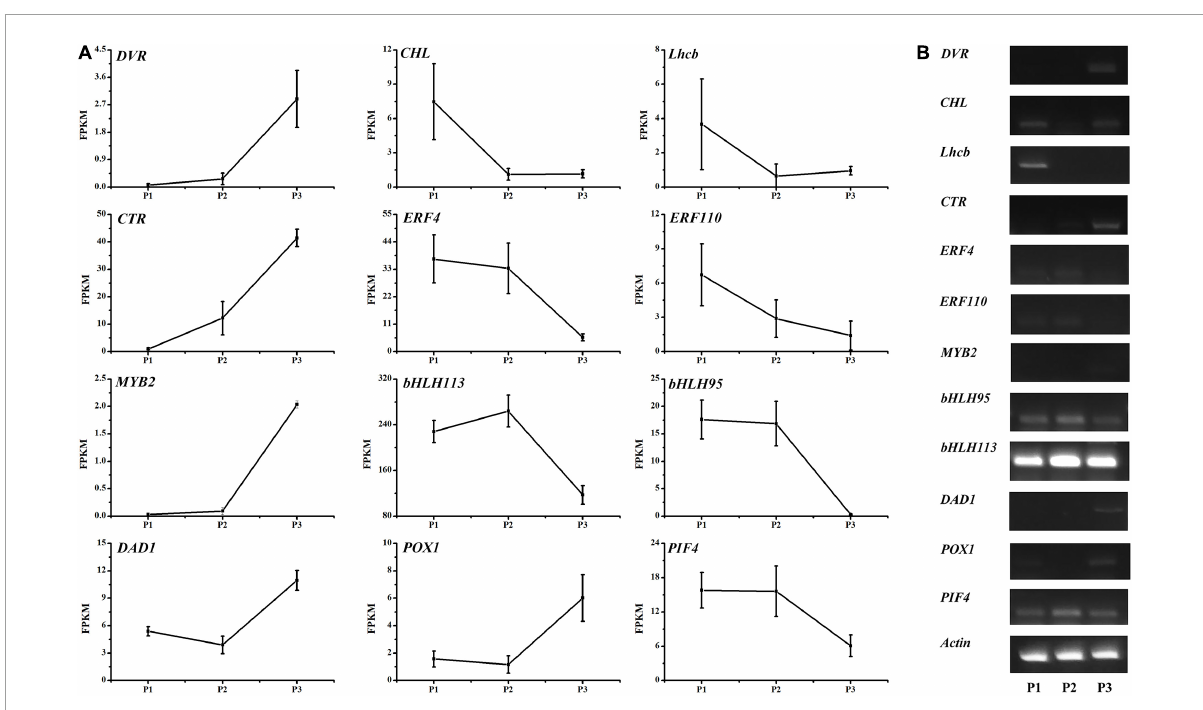
FIGURE6 Expression levels of 12 differentially expressed genes in the LM8 pericarp during three developmental stages (P1, P2, and P3). Gene expression levels were analyzed on the basis of RNA-seq FPKM values and sqRT-PCR data. Actin was used as the control.